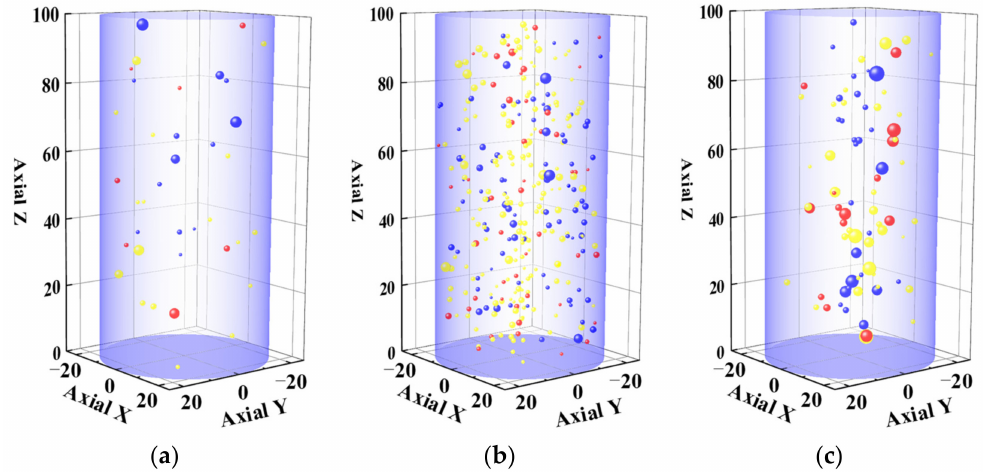
Figure 19. AE moment tensor inversion results for F3-3 at different fatigue crack growth stages. ( a ) Fatigue crack initial propagation stage; ( b ) fatigue crack stable propagation stage; ( c ) fatigue crack unstable propagation